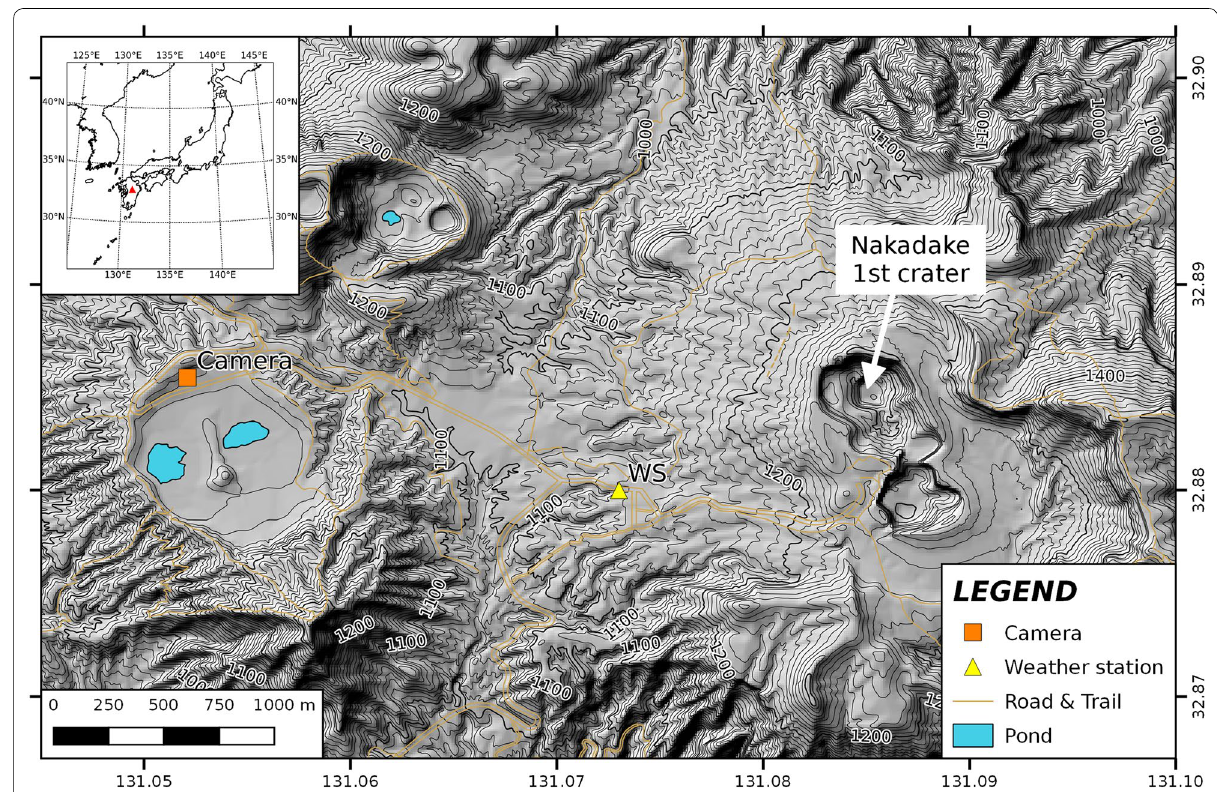
Fig. 1 Location of monitoring camera and the crater of Aso volcano. Location of Aso volcano is depicted with the red triangle in the inset. Data of the base map are from Geospatial Information Authority of